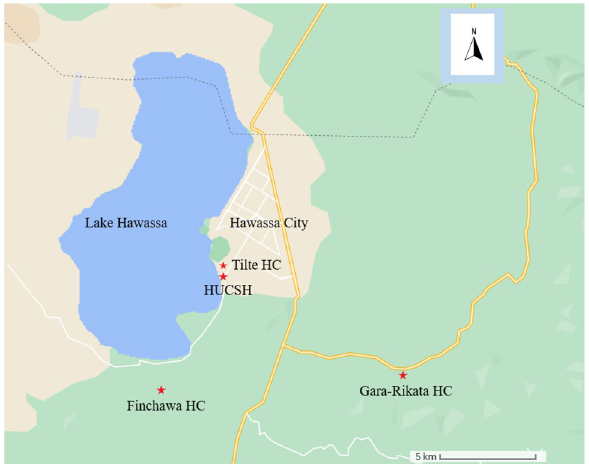
Figure 1. Study sites, Hawassa City, 2019. HC health centre, HUCSH Hawassa University Comprehensive Specialized